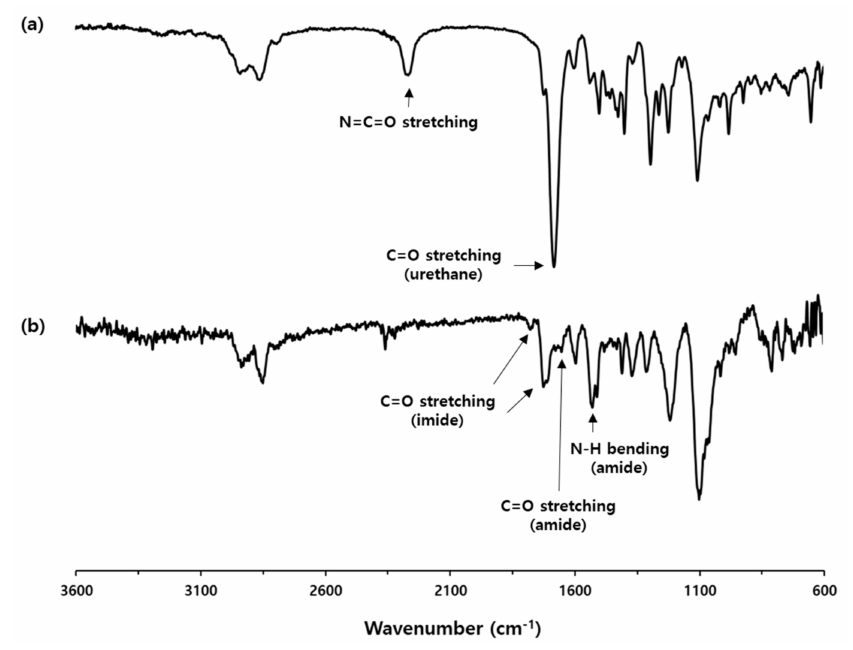
Figure 2. FTIR spectra of ( a ) an isocyanate-terminated oligomer and ( b )